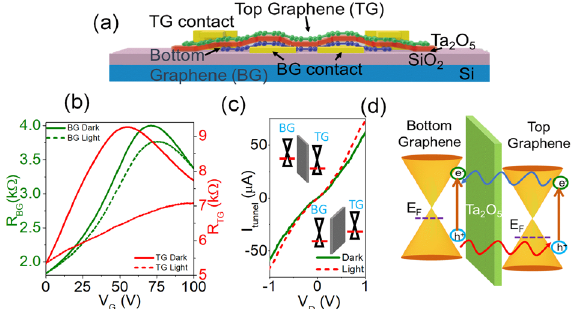
Figure 1. Graphene/Ta 2 O 5 /graphene ( a ) device schematic (not to scale). ( b ) R vs. V G for bottom ( R BG ) and top ( R TG ) graphene in dark and under illumination of 405 nm wavelength. ( c ) Tunneling current from top graphene to bottom graphene layer as a function of drain source voltage V D between the two layers, while the substrate experiences a global back-gate voltage of 80 V, in dark and under illumination. The dielectric strength of SiO 2 6 is 10 7 V/cm and for Ta 2 O 5 is 8 × 10 V/cm 43 . ( d ) Band diagram of graphene/Ta 2 O 5 /graphene heterostructure highlighting the mechanism of photocurrent generation on top graphene